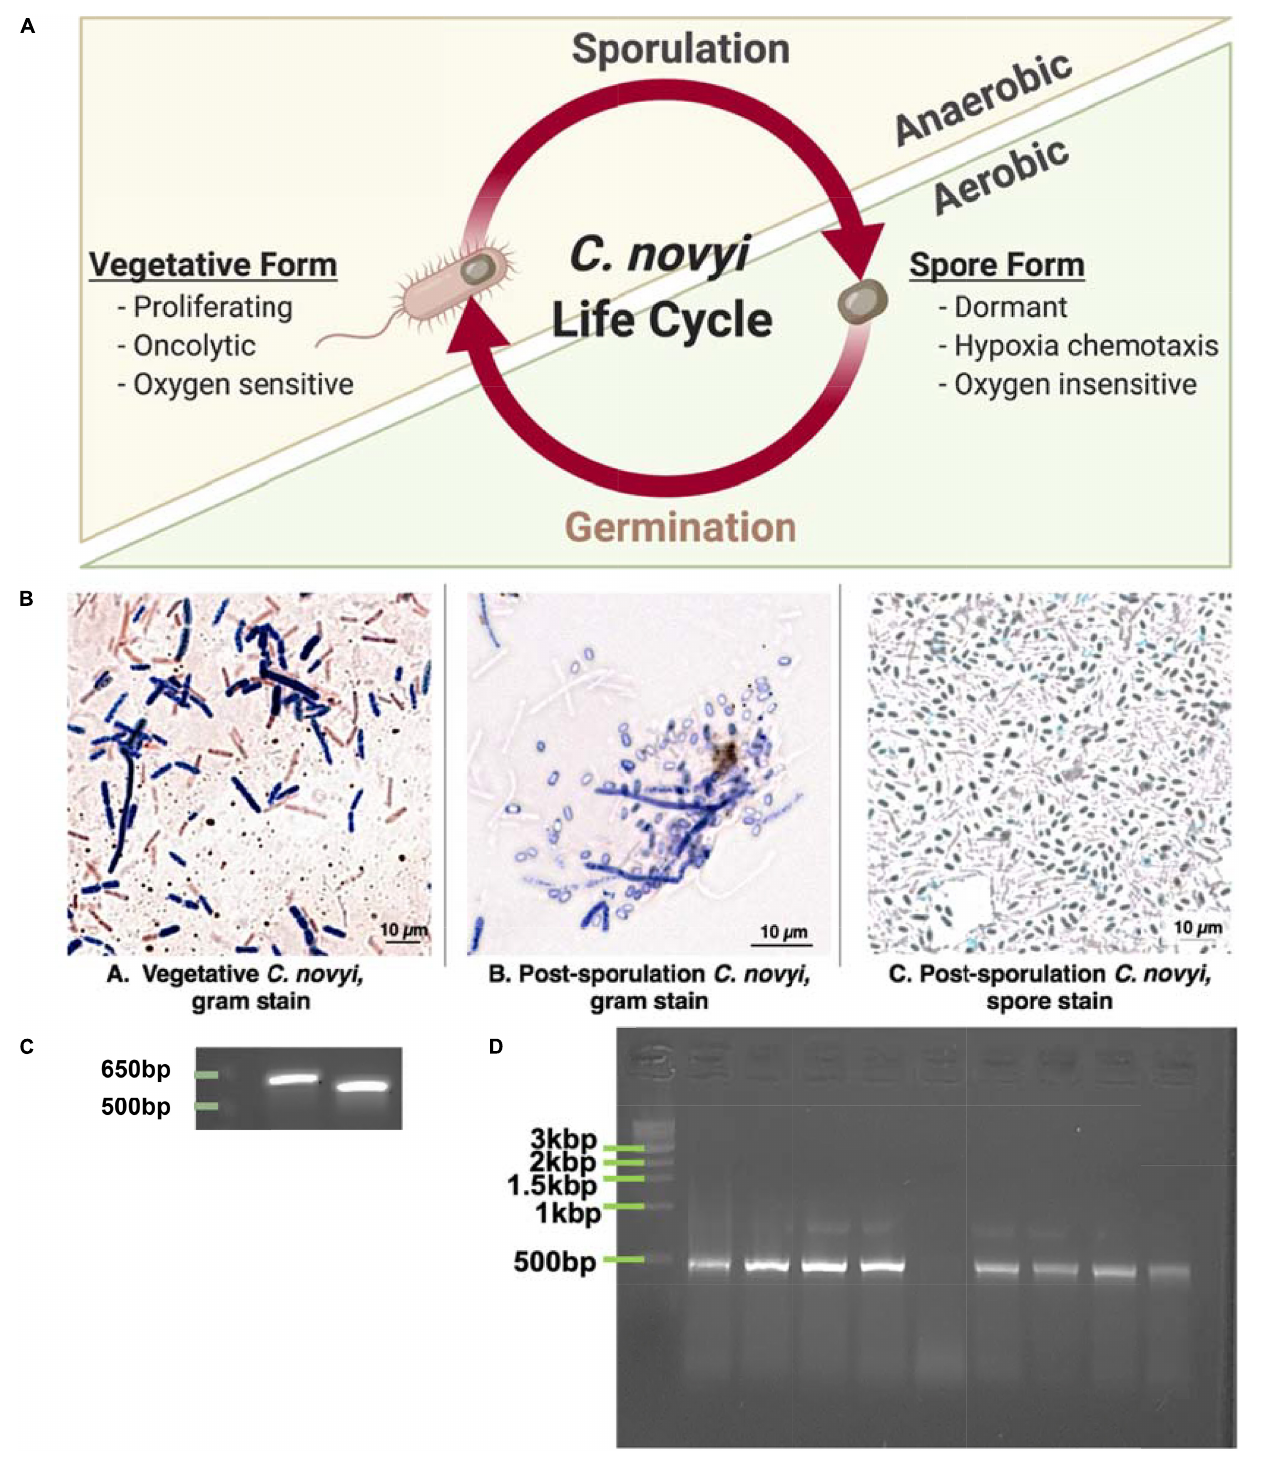
FIGURE 1 | Demonstrating ability to grow C. novyi. (A) Schematic representation of Clostridium novyi life cycle. (B) Brightfield images captured under oil-immersion at 40 × . From left to right: (a) Gram stain of vegetative C. novyi , (b) Gram stain of C. novyi post –sporulation, (c) Malachite green spore stain of post-sporulation C. novy i. (C) PCR amplicons primers designed with specificity to C. novyi 16s rRNA and α -toxin. (D) PCR amplification with C. novyi α -toxin primers after α -toxin knockout was performed.